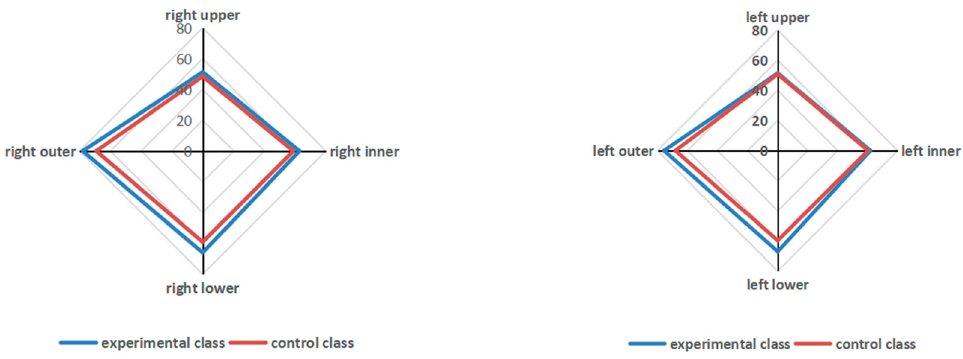
Figure 3. Comparison of visual fields in the left and right eyes between G4 and Control in Assessment